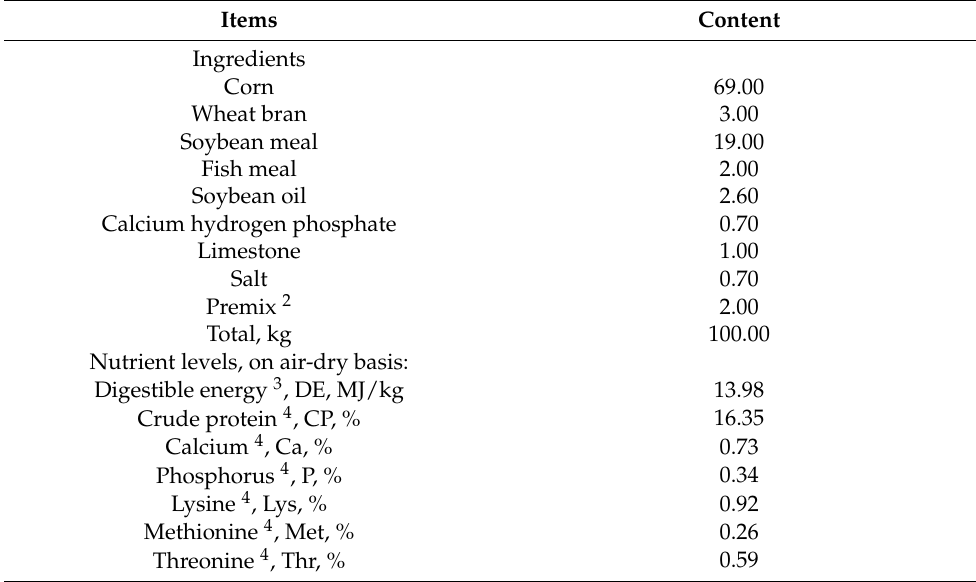
Table 1. Composition (kg/100 kg) of the basal experimental diets 1 for gestating and lactating sows.